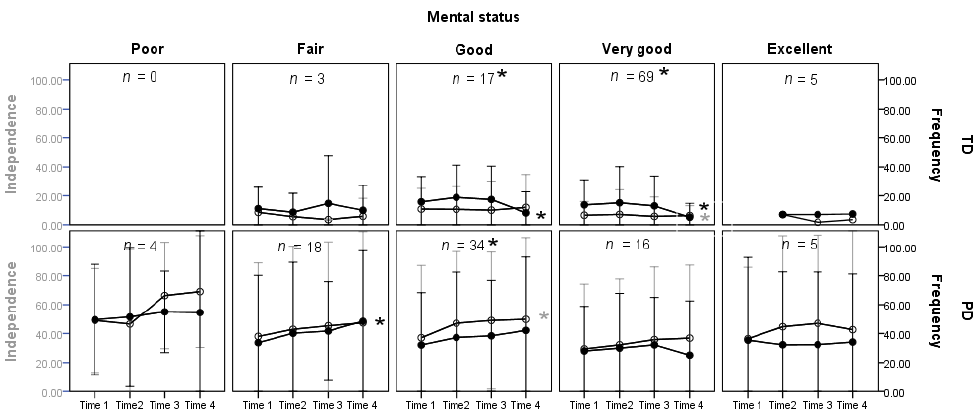
Figure 2. Independence and frequency of attendance gap by groups (TD vs. PD) across four time points by the five mental status of children. Note. TD = typically developing children; PD = physical disability; dark point ( • ) and black line with 1 SD error bar illustrate the frequency of attendance scores; circle point ( ○ ) and gray line with 1 SD error bar illustrate the independence scores; dark star sign (*) beside Time 4 presents a significant trend for frequency of attendance; gray star sign (*) beside Time 4 presents a significant trend for independence. Dark star sign (*) beside the case number presents significant independence–frequency of attendance gap trends in that block.